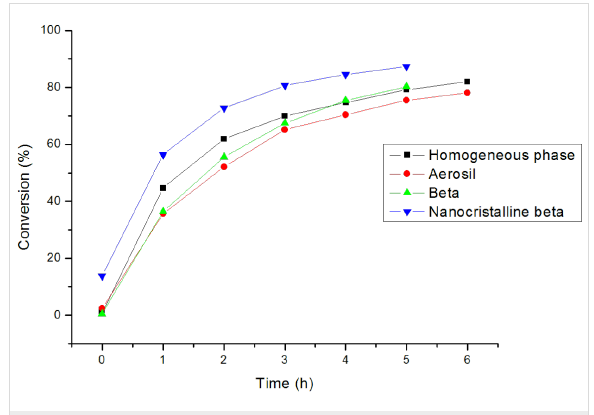
Figure 1: Conversion in the DAR catalysed by silica Beta zeolites and